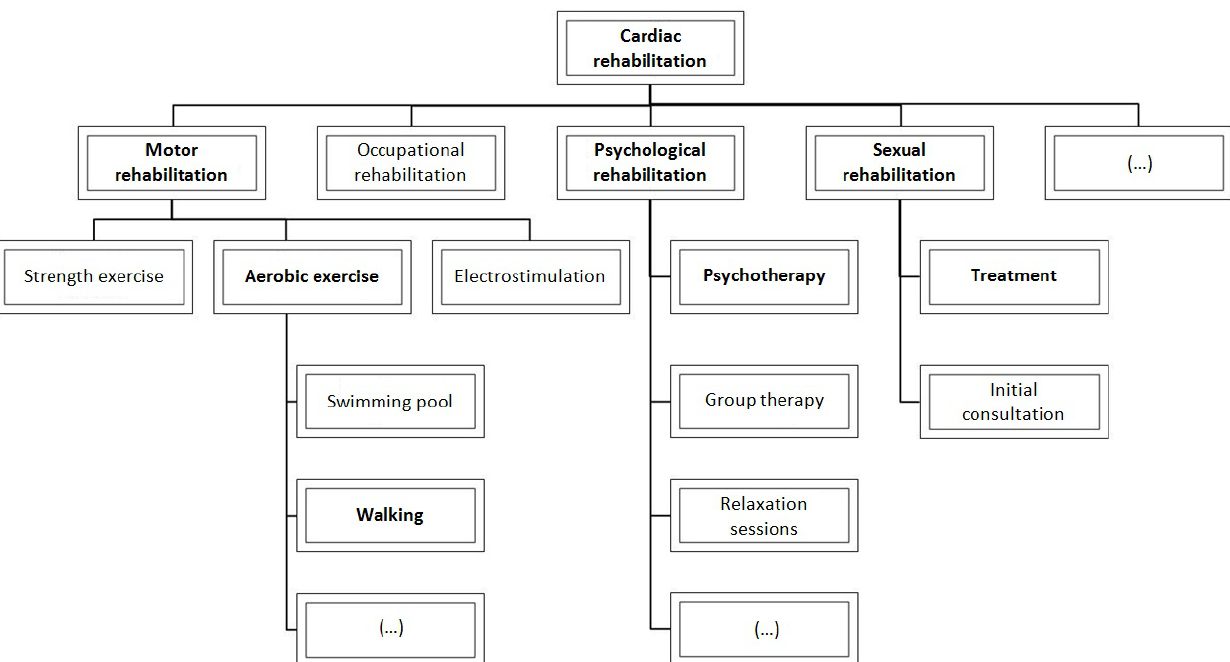
Figure 1. Cardiac rehabilitation’s map of